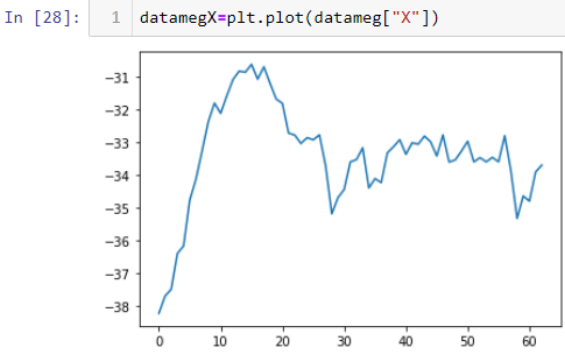
39 of 53 Figure 46. Gyroscope z -axis data for point_1. Figure 47. Magnetic x -axis data for point_1.